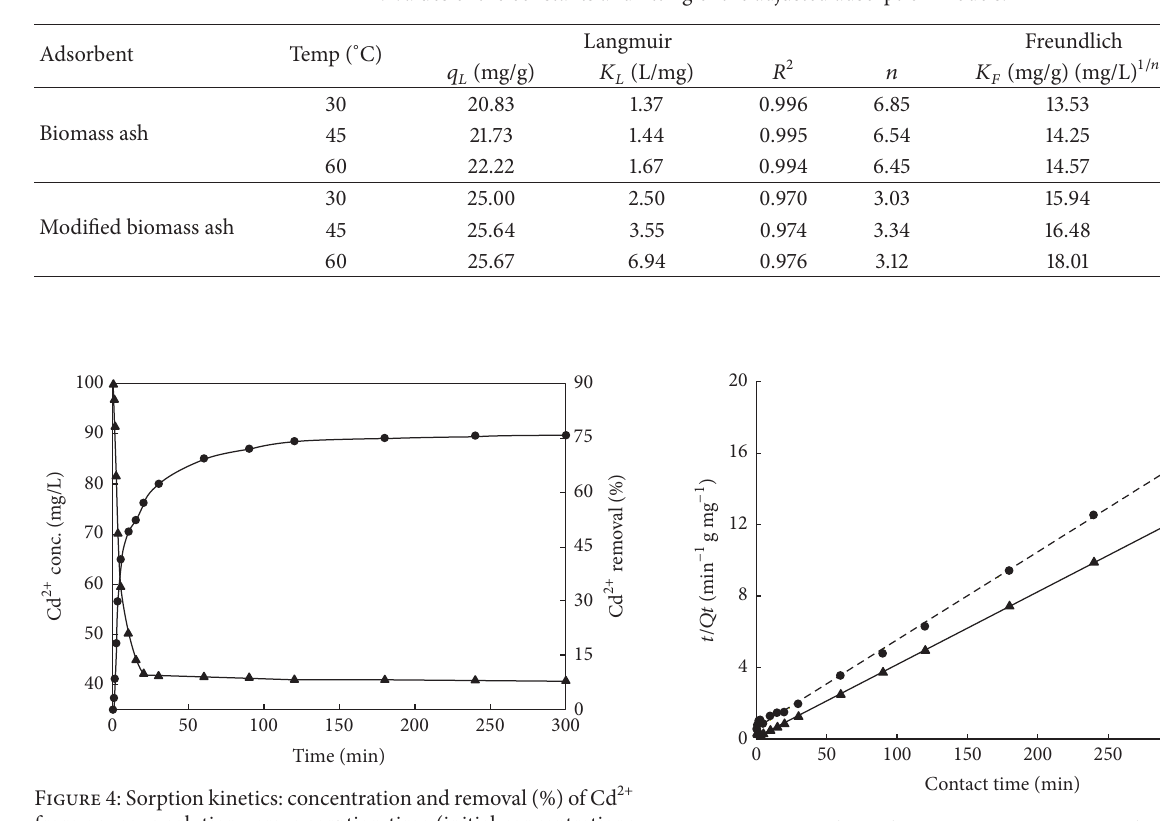
Table 4: Values of the constants and fitting of the adjusted adsorption models.